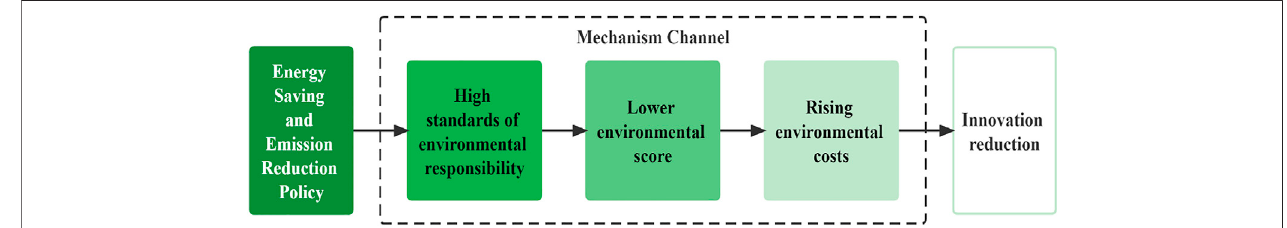
FIGURE 1 | Variable relationships.